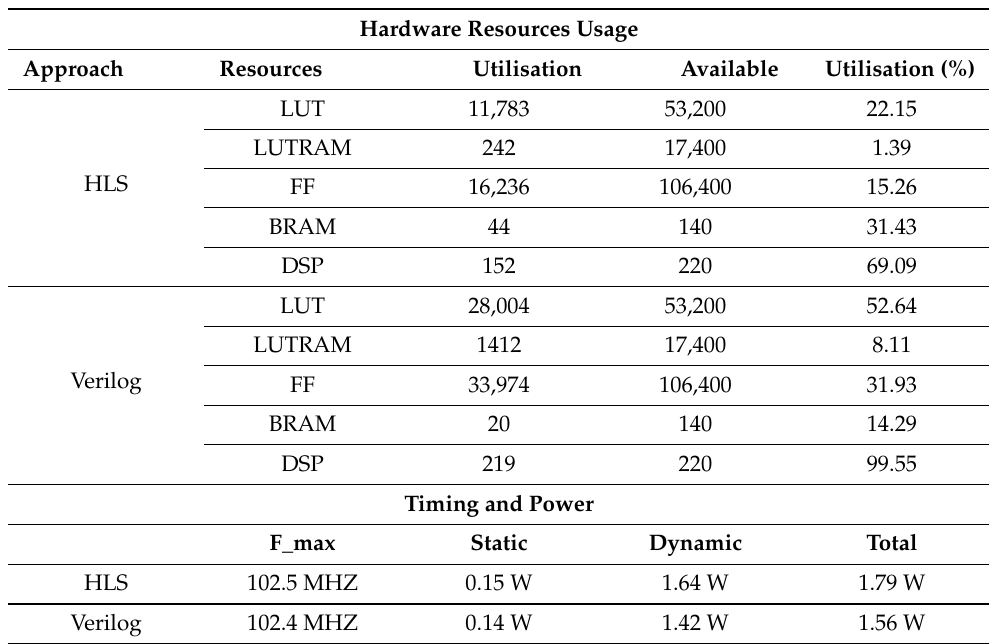
Table 7. The UNSW-NB15 dataset implemented results on PYNQ-Z2 SoC FPGA.